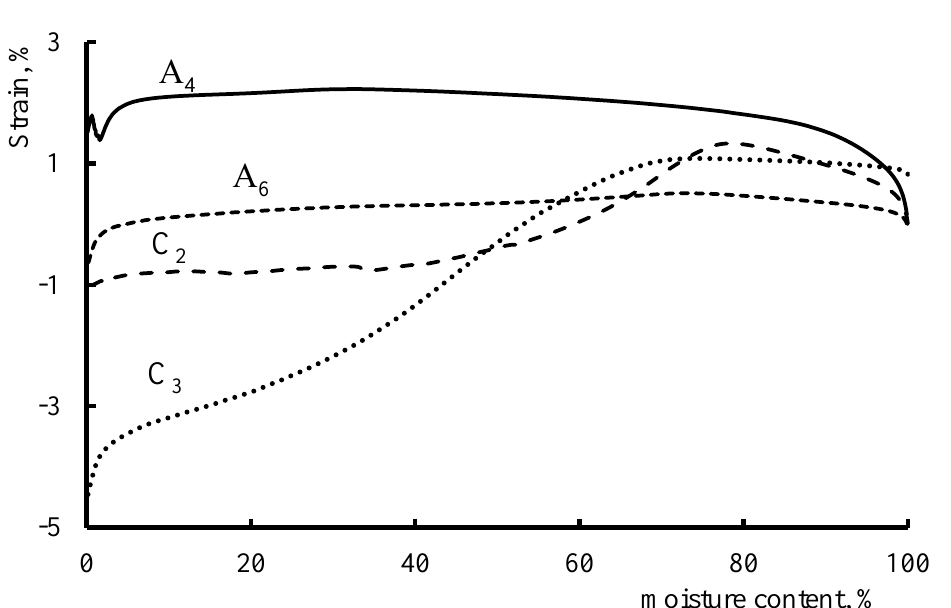
Figure 10. Influence of moisture content on the deformation of anionite and cationite fragments of membranes at a constant external tensile load; N: A 4 –3, A 6 –1.5; C 2 –3, C 3 –1.5.